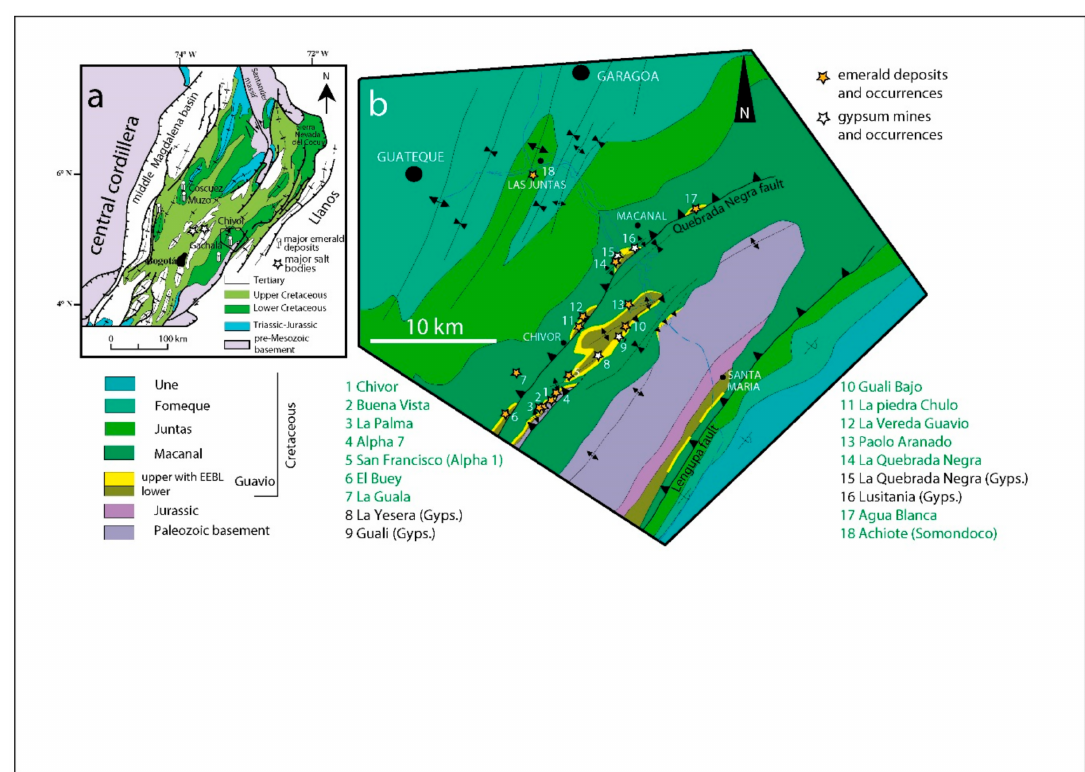
Figure 27. Deposits from the eastern emerald zone in Colombia:( a ) Simplified geological map of the Eastern Cordillera with the location of the main emerald deposits. Inset is the location of Figure 27b; ( b ) geological map of the Chivor area. All emerald and gypsum deposits and occurrences are hosted within the Berriasian Upper Guavio Formation.